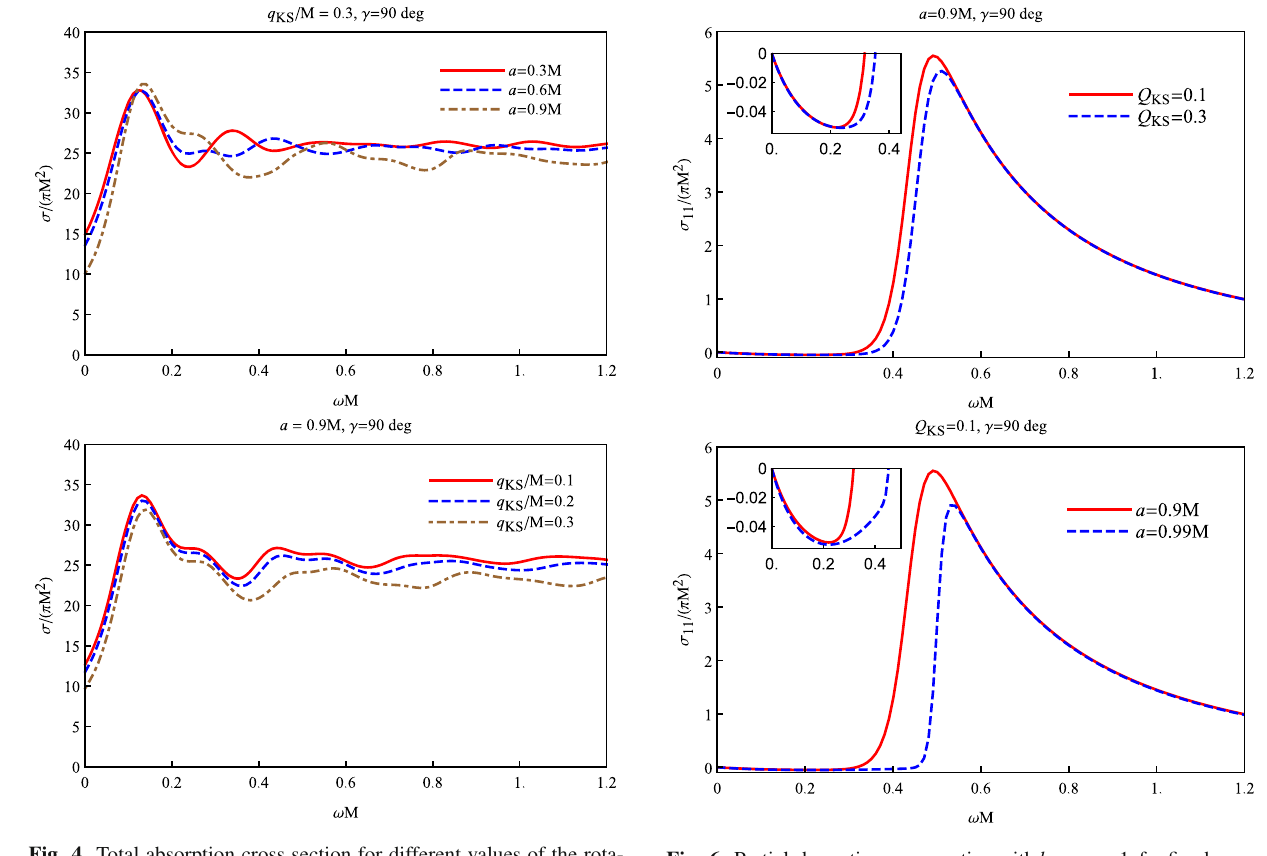
note that as we move away from the on-axis case ( γ = 0 deg), the behavior of the absorption cross section is less regular.